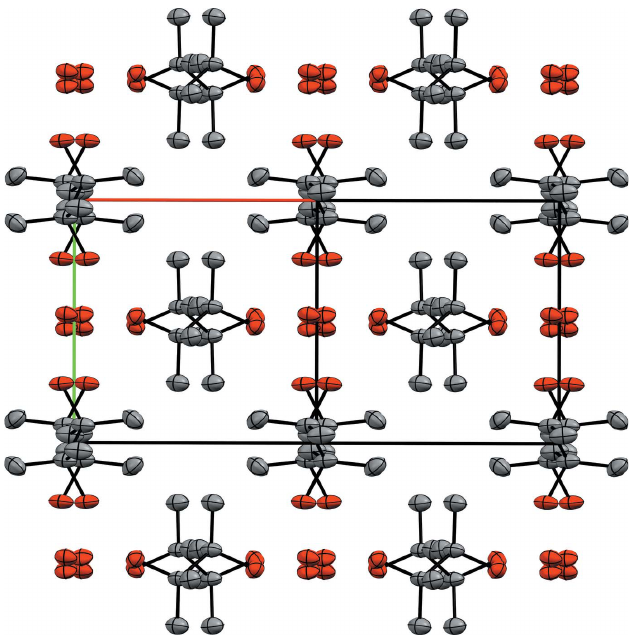
Figure 14 The propensity for pseudo-tetragonal fourfold twinning in SAXDUR is clearly demonstrated in a packing plot for one individual viewed along [101], which is the fourfold twin axis relative to the P 2/ n unit cell. Diagram generated using Mercury (Macrae et al. ,